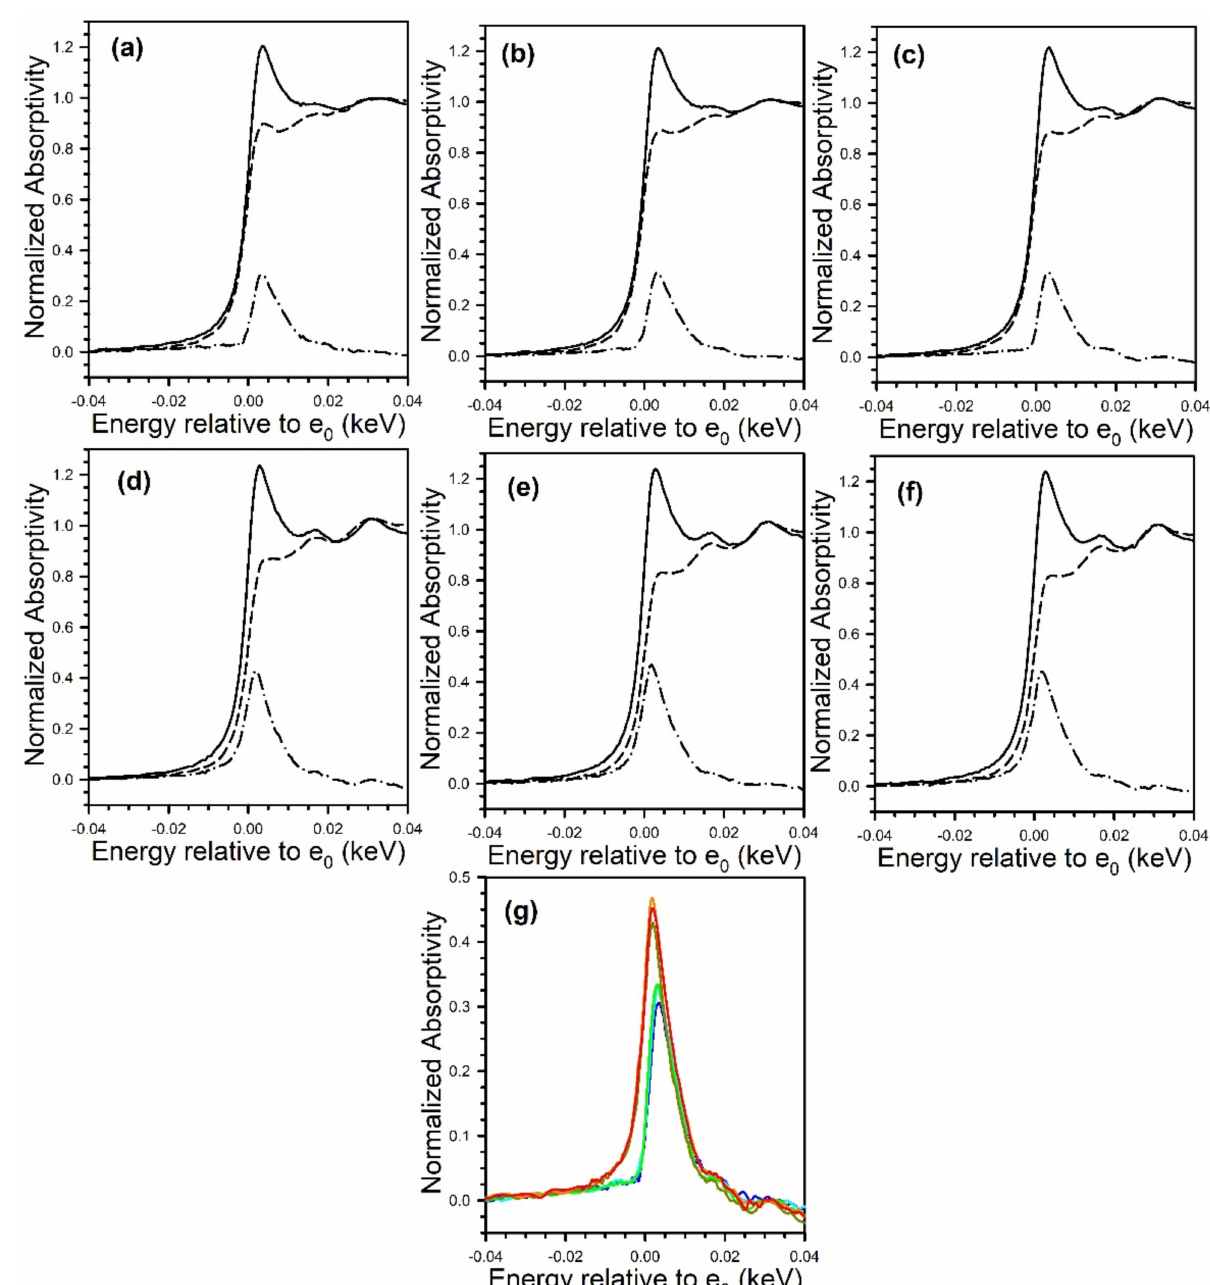
Figure 14. XANES and L 3 -L 2 XANES difference spectra at the (dashed line) Pt L 2 edge and (solid line) Pt L 3 edge following reduction in pure hydrogen and cooling to ambient temperature, including 2% Pt/ZrO 2 with: ( a , blue) 0% K; ( b , cyan) 0.85% K; ( c , green) 1.70% K; ( d , dark yellow) 2.55% K; ( e , orange) 3.40% K; and ( f , red) 4.25% K. ( g ) Overlays of L 3 -L 2 difference spectra, showing an increase in intensity with K loading. No evidence for e - transfer to Pt from K + was